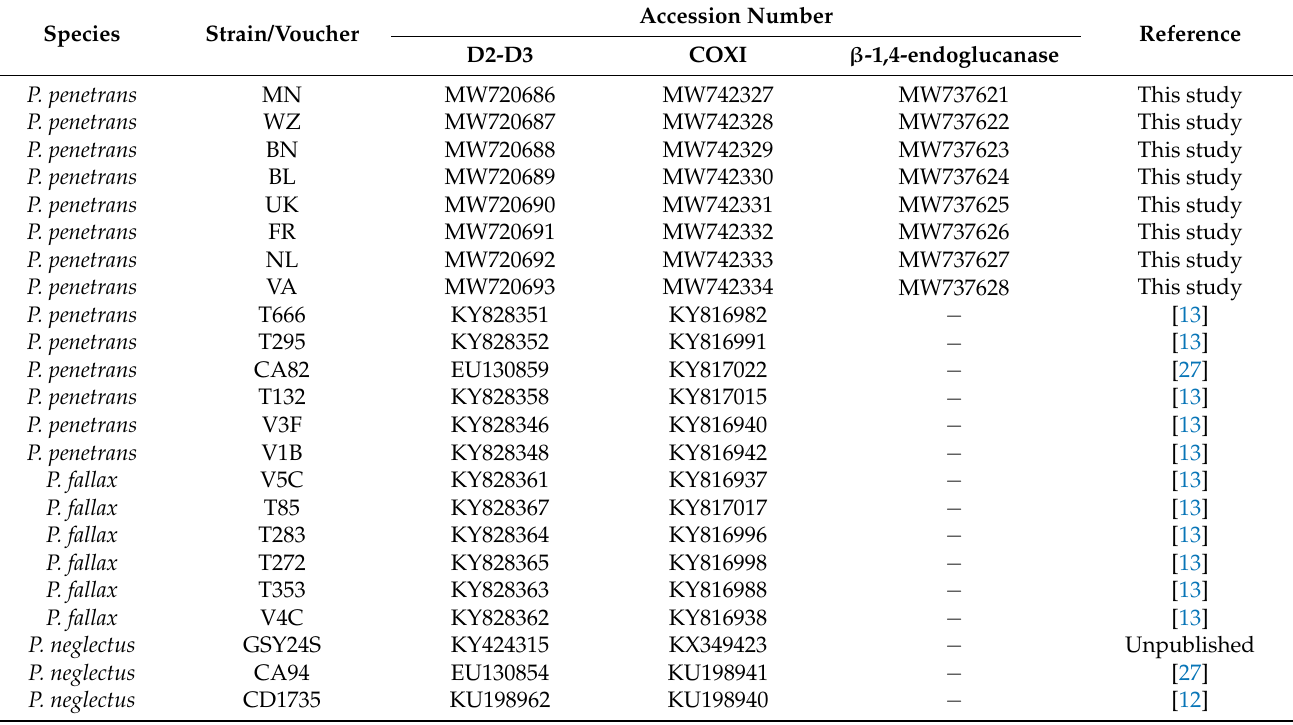
Table 2. Sequences used/generated in this